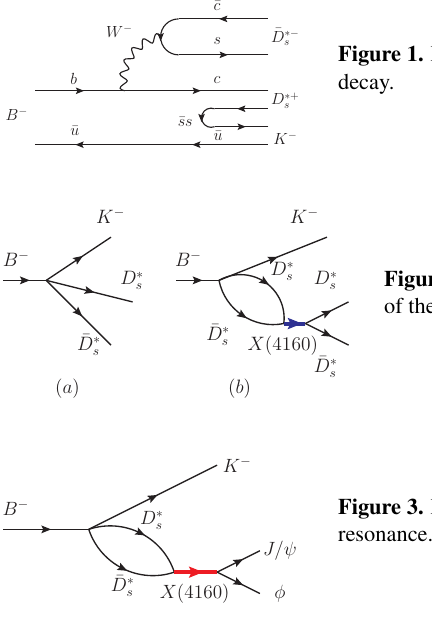
Figure 1. Microscopic quark level production of K − D ∗ s ¯ D ∗ s in B − decay.